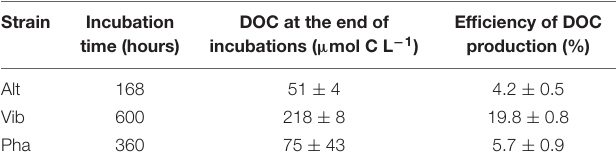
TABLE 2 | Efficiencies of dissolved organic carbon (DOC) production from glucose by the bacterial